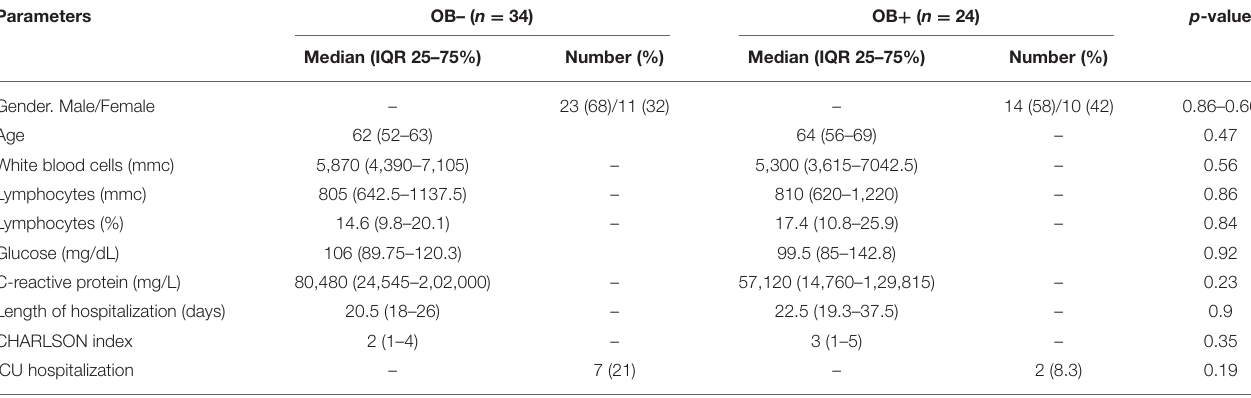
TABLE 2 | Demographic and clinical characteristic of OB– and OB + SARS-CoV-2-infected patients. Parameters